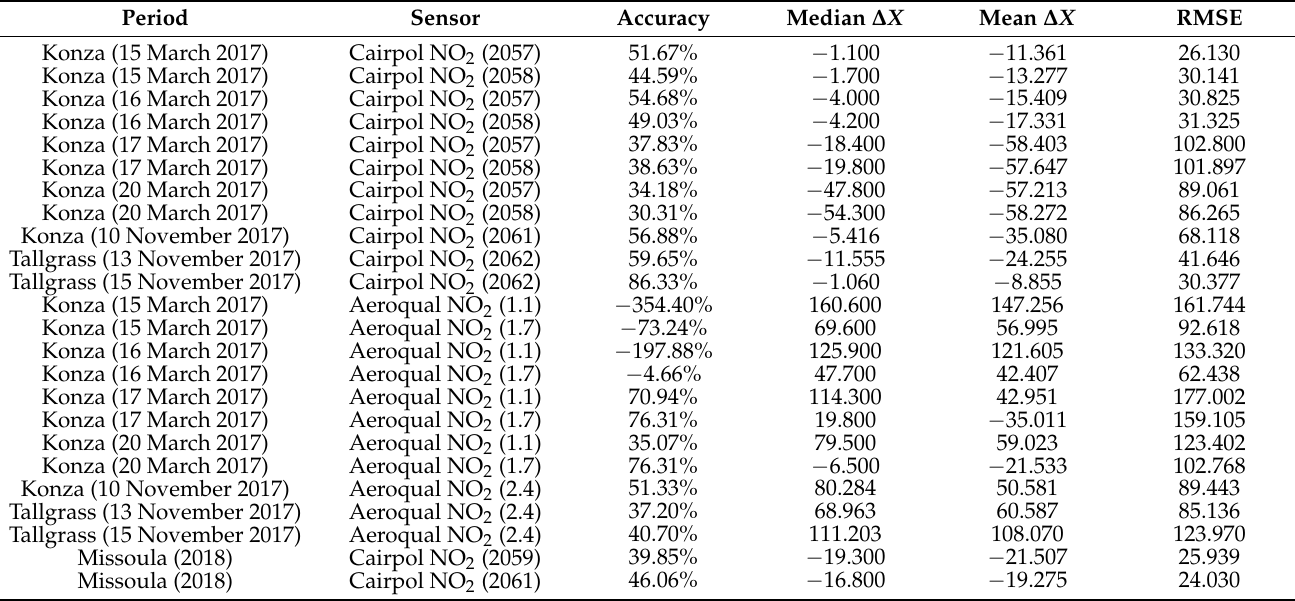
Table A6. Sensor versus reference difference statistics for NO 2